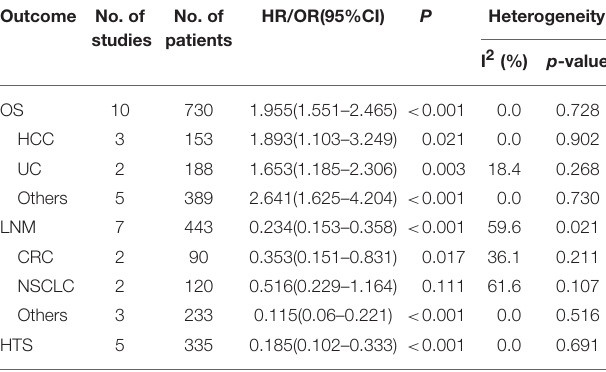
Frontiers in Physiology |